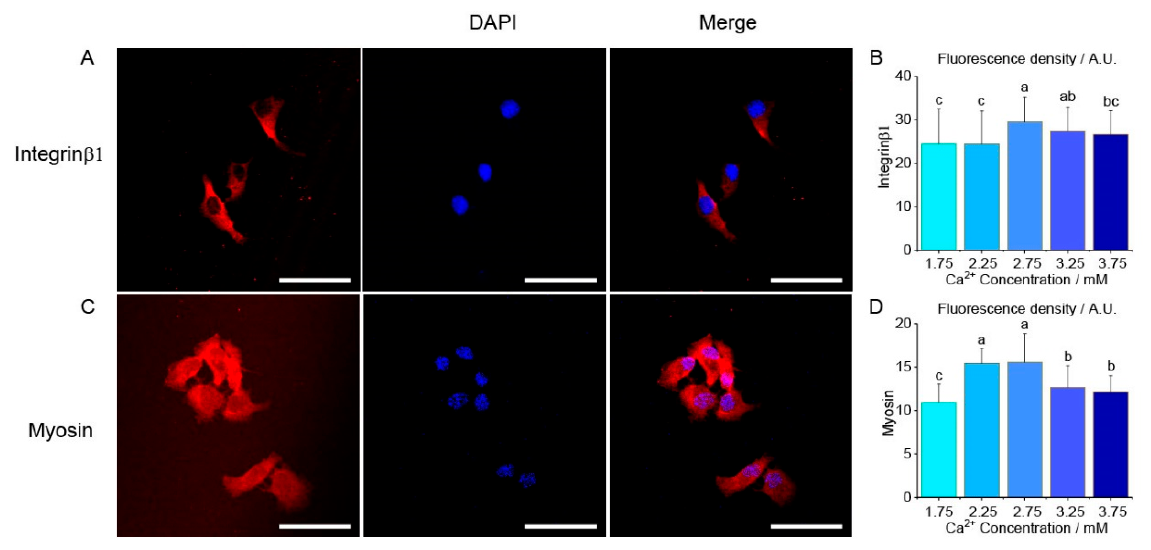
Figure 6. The effects of extracellular Ca 2+ concentration on human chondrocytes myosin and integrin β 1 fluorescence den- sity. ( A ) A representative integrin β 1 fluorescence image taken at 1.75 mM Ca 2+ concentration. Scale bar 50 μ m; ( B ) As Ca2+ concentration increases, fluorescence density of integrin β 1 increased by 20% from 1.75 mM to 2.75 mM, and then decreased from the 2.75 mM group to 3.75 mM. ( C ) A representative myosin fluorescence image taken at 1.75 mM Ca 2+ concentration. Scale bar 50 μ m; ( D ) As Ca 2+ concentration increases, fluorescence density of myosin increased by 50% from 1.75 mM to 2.75 mM and then decreased by 20% from 2.75 mM to 3.75 mM. 60 cells are measured and analyzed in each group. Letters (a, b, c) above the bars in ( B , D ) correspond to distributions that are (letters different) or are not significantly different (letter shared) at the p < 0.01 level.